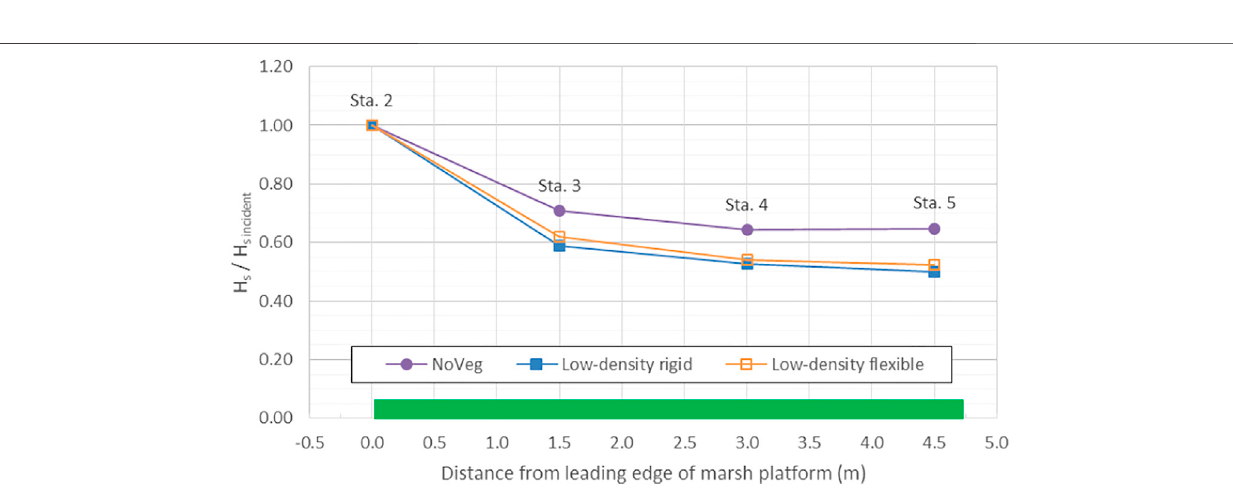
Frontiers in Built Environment |